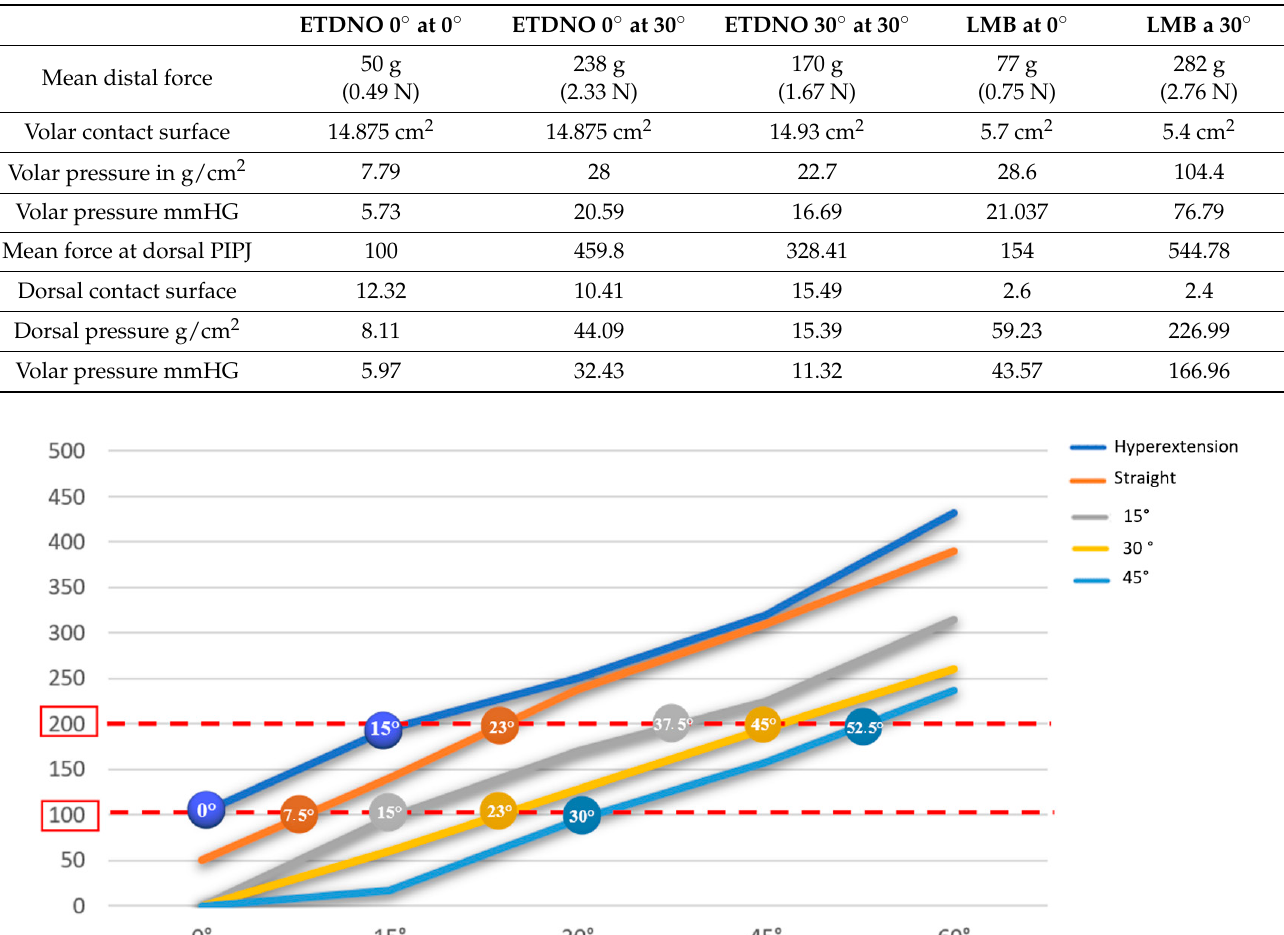
Table 4. Orthosis forces, contact surfaces and pressure pattern on straight tube ETDNO, 30 ◦ flexed tube ETDNO and LMB 501 orthosis.